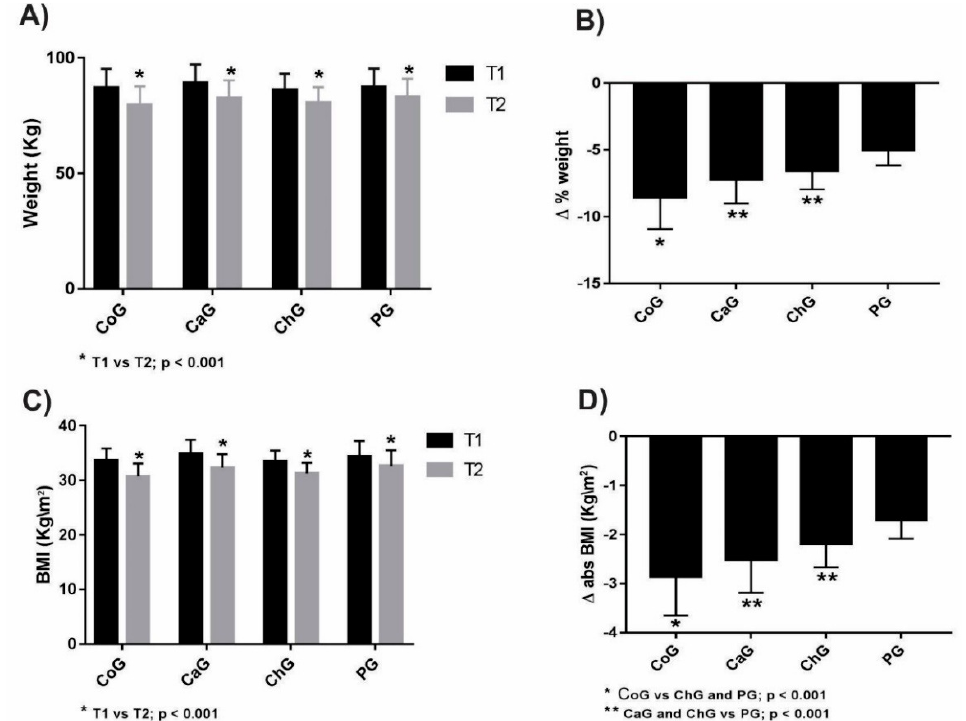
Figure 2. Variation of weight loss and body mass index (BMI). Percentage weight loss ( A ) and absolute BMI loss ( C ) (T1 vs. T2). Absolute weight variation ( B ) and BMI variation ( D ). Results presented in mean + standard deviation. T1 = Value one week before (T1) and one week after (T2) supplementation protocol; Δ = T2 − T1. CoG—Group supplemented with coconut oil; SafG—Group